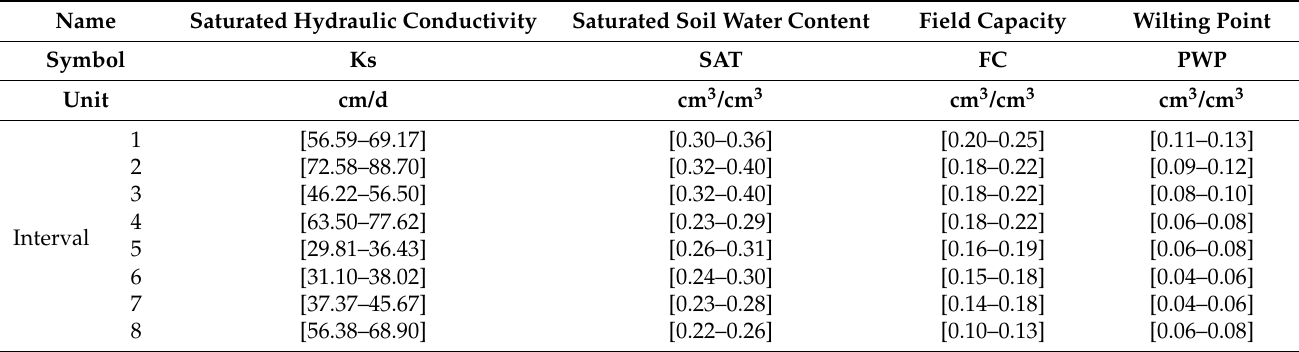
Table 1. Soil hydraulic parameters selected for calibration.